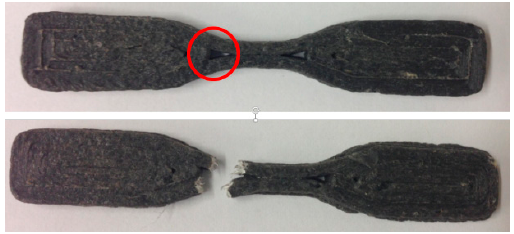
Figure 19 . Location of gaps in the build pattern ( top ); and the premature failure site ( bottom ).